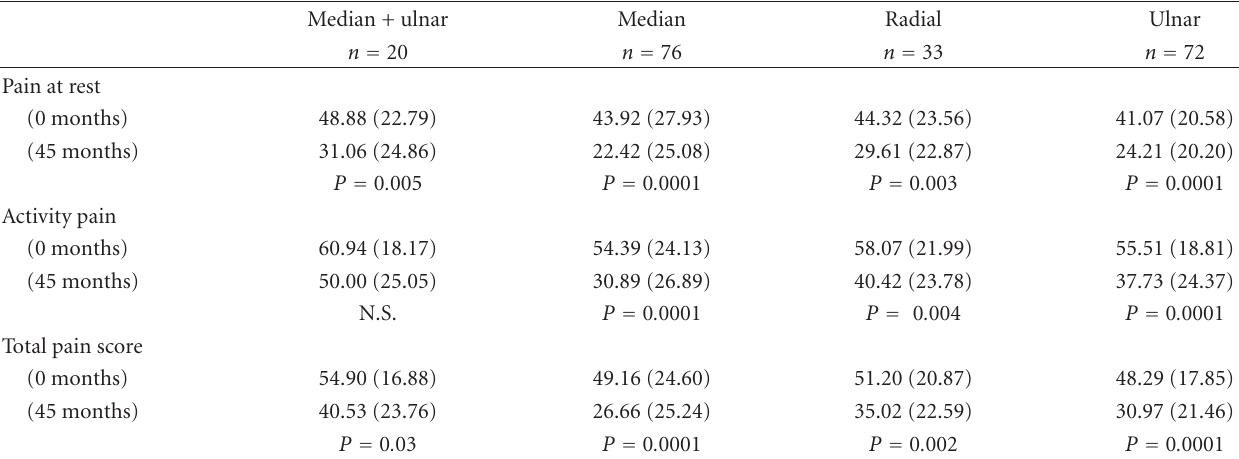
Table 4: The results from the pain VAS recordings (mm). Mean values, SD, and P values are